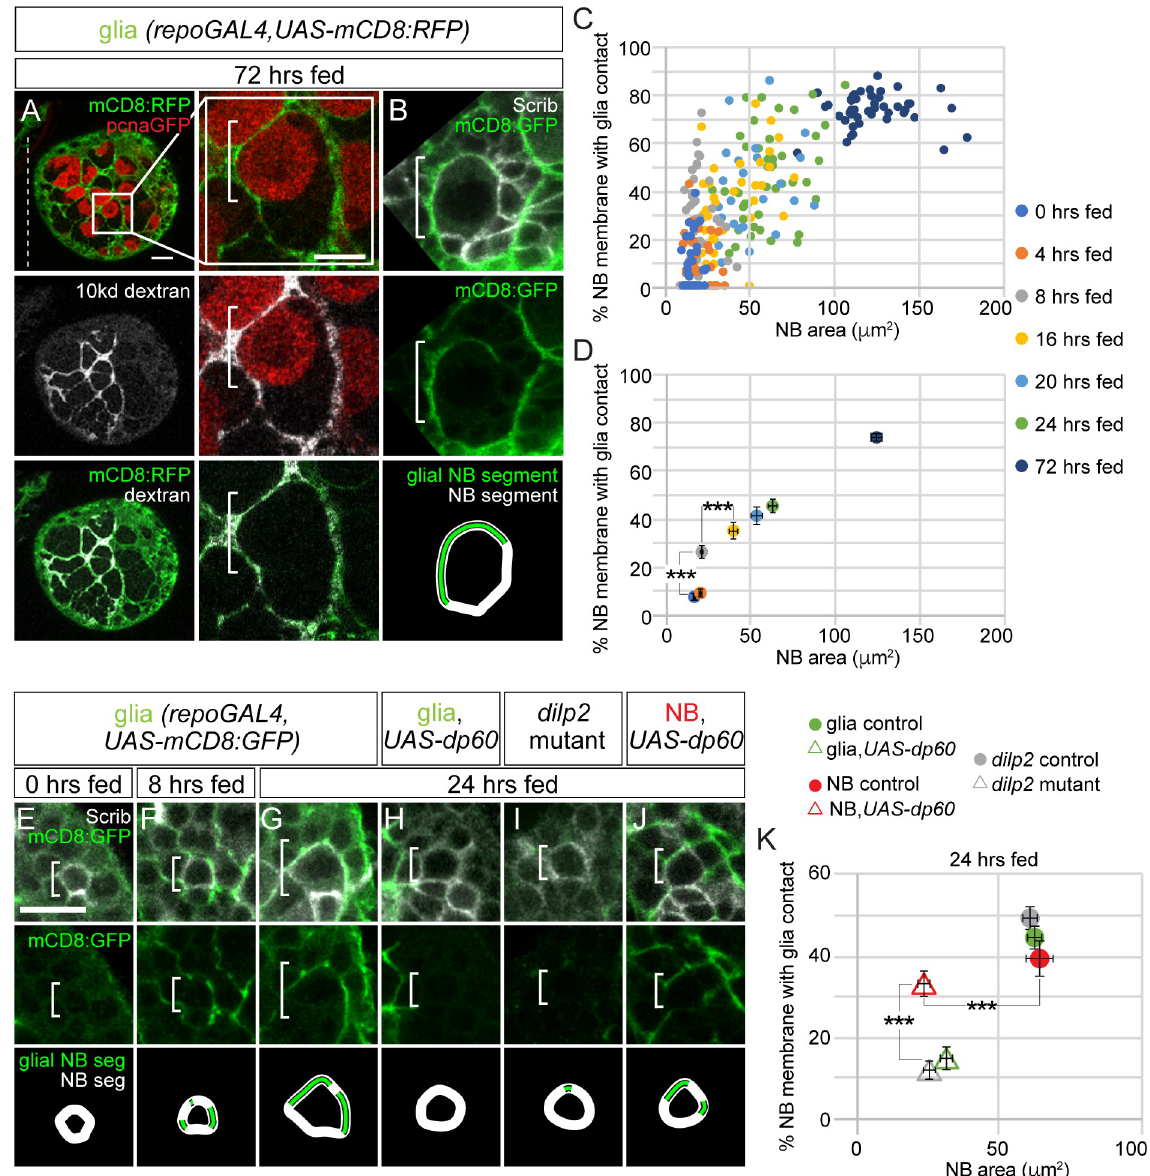
Fig 7. Cortex glia ensheathe NBs and their progeny and provide a niche-like barrier function. (A) Top panel, colored overlay with RFP marking glial membranes and GFP marking pcnaGFP -expressing NBs. Middle panel, single-channel grayscale image of 10-kDa dextran. Bottom panel, colored overlay with 10-kDa dextran and RFP marking glial membranes. To the right, high-magnification images of the boxed NB, with double-labeled glial membrane in a 72-hour–fed animal after dextran injection (see Materials and Methods). (B) Cortex glia ensheathe NBs (white bracket) and their newborn progeny, which express high levels of Scrib. Top panel, colored overlay. Middle panel, single- channel image with GFP marking glial membranes. Bottom panel is a depiction of the glial and NB segments used for quantification in (C,D,K) (see Materials and Methods). (C,D) Percentage of NB membrane in contact with glial contact over time. Colored circles in (C) indicate individual NBs, and colored circles in (D) indicate averages for the indicated time points. Both are plotted relative to NB area. (E–G) Increasing surface contact between NBs and glia membrane over time. Single Z-plane of representative NBs at different time points after feeding. Top panels are colored overlays, middles panels are single-channel images, and bottom panels depict the glial NB segment and NB segment used in quantification (C–D). (H–K) Top panel colored overlay, middle panel single-channel image, and bottom panel glial NB segment and NB segment used in quantification of animals at 24 hours of feeding with genotypes listed above. (D,K) One-way ANOVA with Tukey post hoc analysis, ��� p < 0.001. Genotypes of panels listed in S2 Table and data listed in S1 Data. Dilp, Drosophila insulin-like peptide; GFP, green fluorescent protein; mCD8, membrane-targeted CD8 antigen; NB, neuroblast; pcna , proliferating cell nuclear antigen; repo , reversed polarity ; RFP, red fluorescent protein; Scrib, Scribble; UAS , upstream activating sequence.